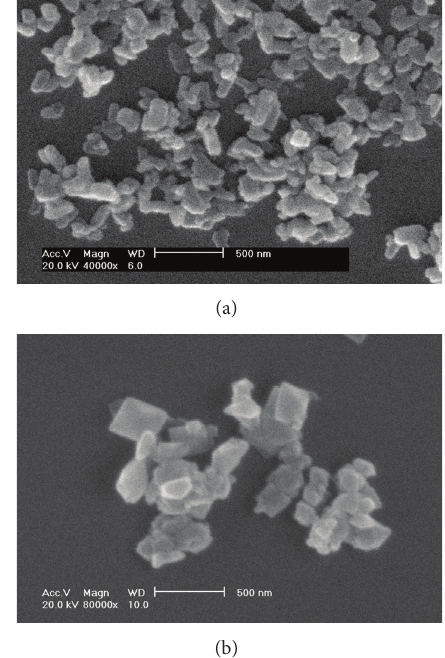
Figure 2: SEM images of submicron CaOxa. (a) COM; (b)